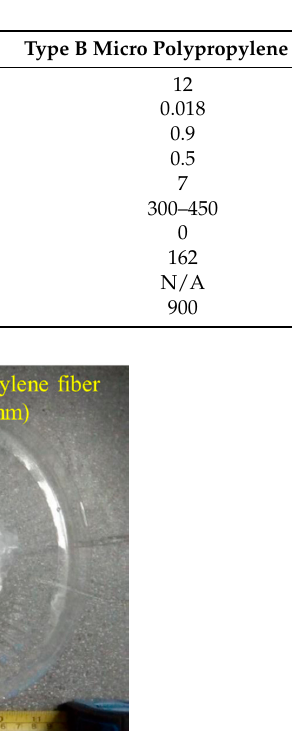
Table 2. Polypropylene Fiber Properties.